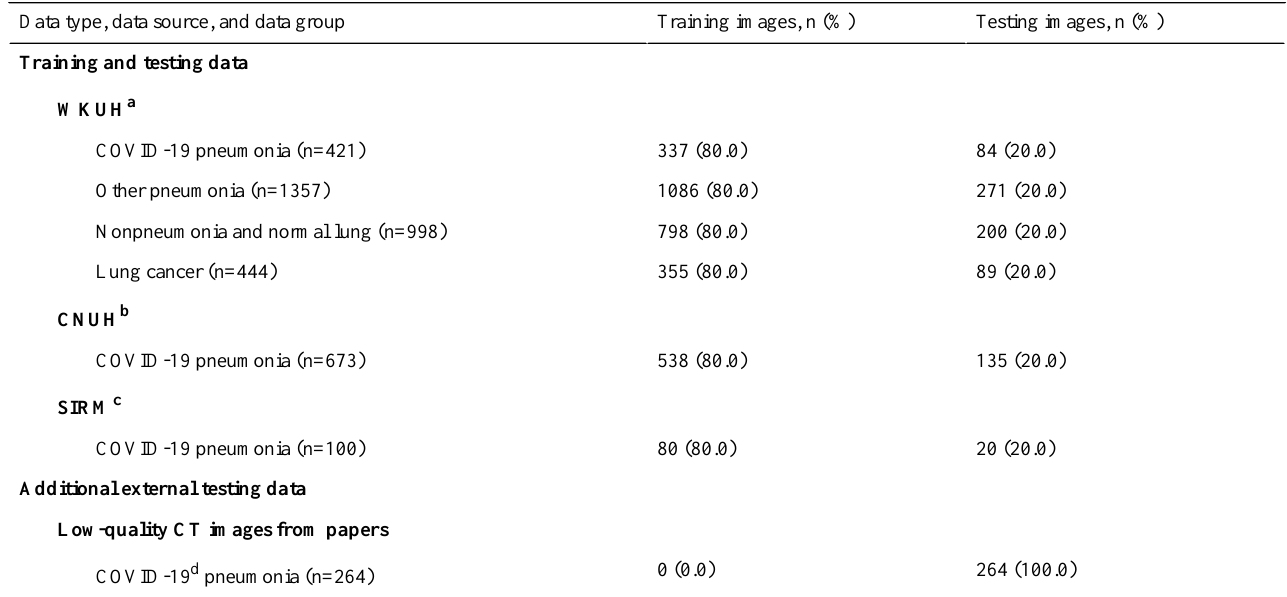
Table 1. Summary of the training, testing, and additional testing data sets